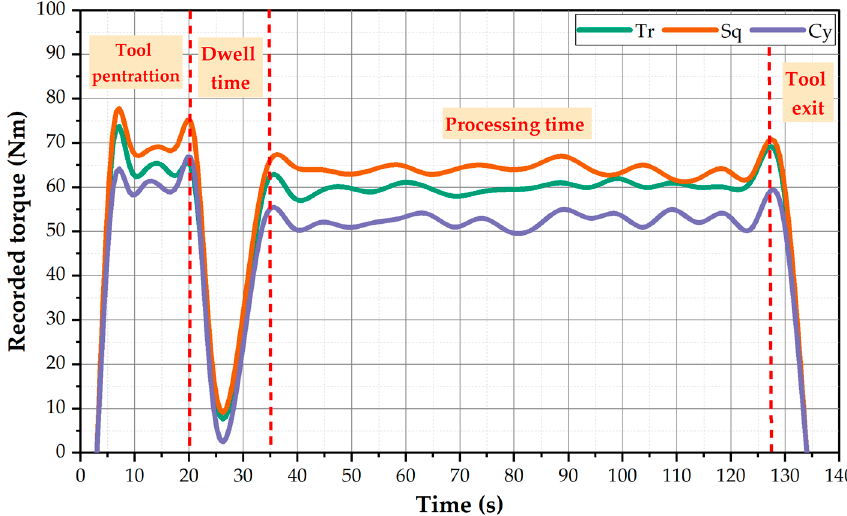
Figure 9. The recorded torque against the BT-FSP time at 600 rpm and 100 mm/min using different pin geometries to process 8 mm AA1050.